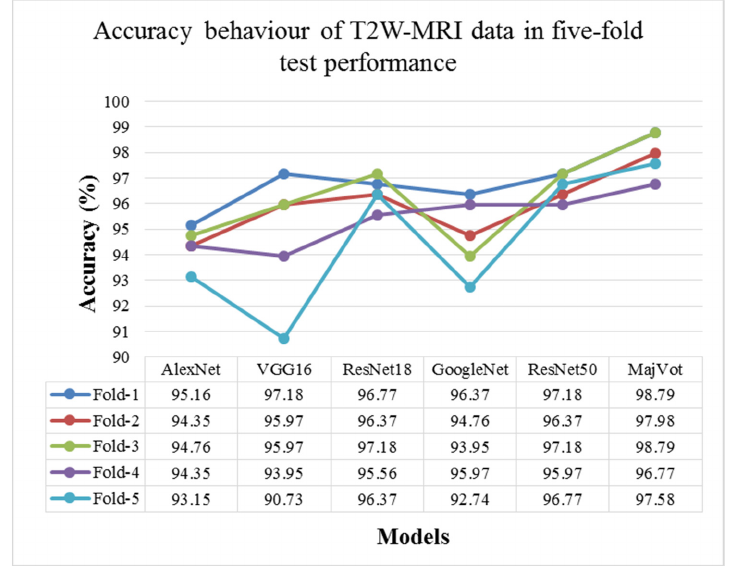
Figure 9. Five-fold test performance of T2W-MRI Data.